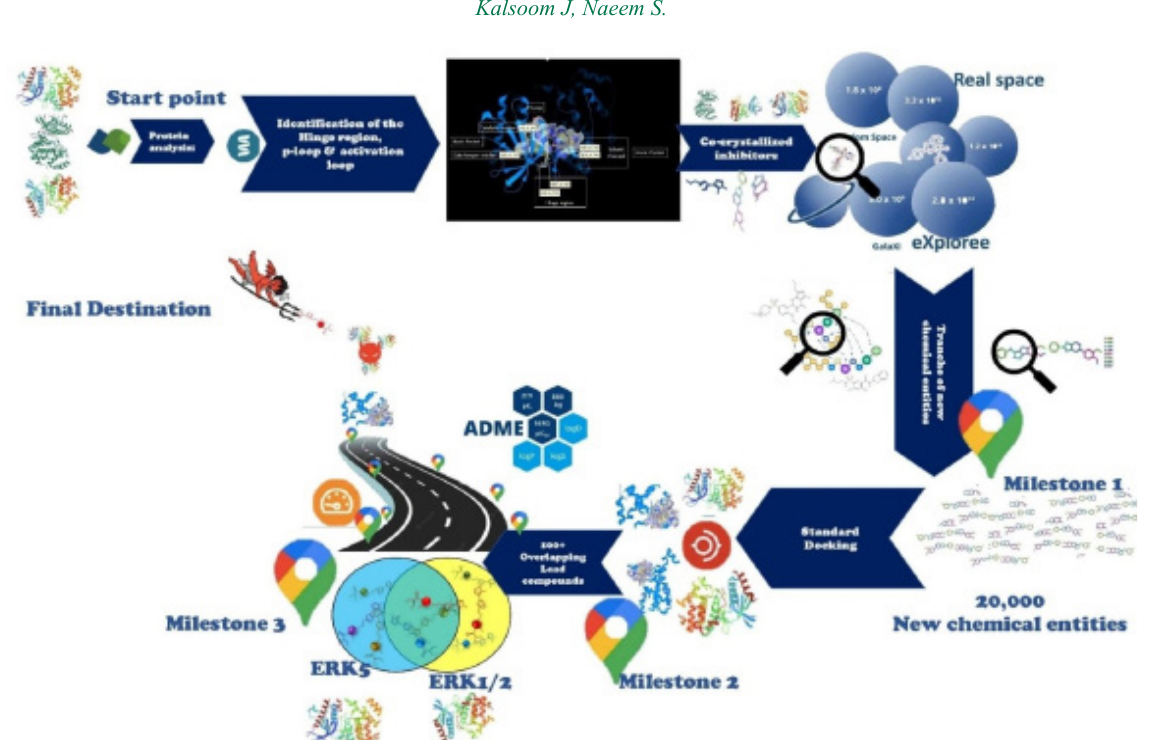
Figure-II: Graphical representation of methodology. catalytic Lys84 and hinge region Met140 and Leu139 in the ATP binding site. Furthermore, the allosteric binding site located in a recess between the p-loop and αC helix, with Lys84, Val68, Glu102, Arg98 and Tyr66, was identified with help of the literature [11]